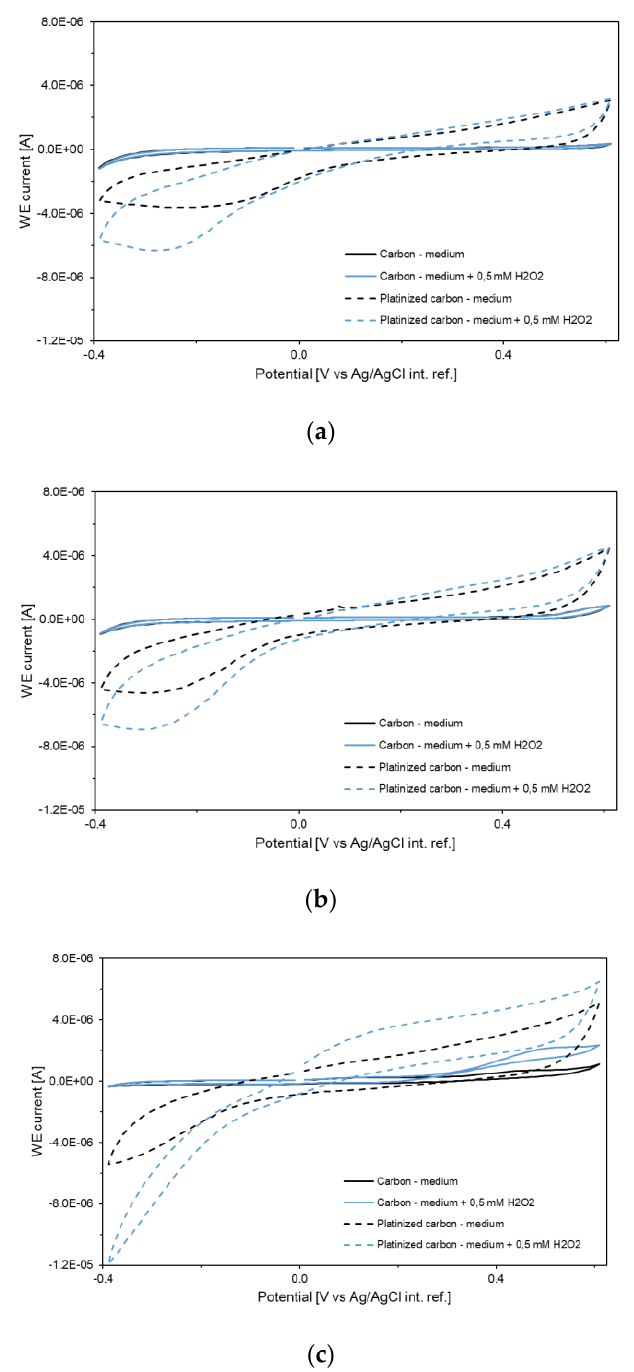
Figure 4. Cyclic voltammetry measurements in three cell culture media using bare and Pt-NP-functionalized carbon electrodes in the absence or presence of 500 µM H 2 O 2 . ( a ) Fujifilm media diluted 1 to 60 in PBS; ( b ) RPMI medium; ( c ) CGXII medium. Voltage is cycled between −0.4 and 0.6 V at a rate of 50 mV/s with a voltage step of 10 mV.